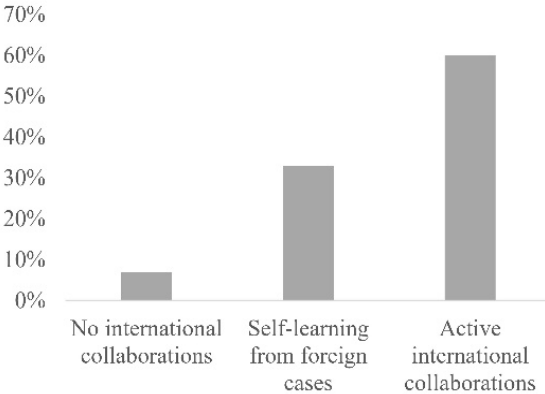
Figure 6. Established international partnerships among Kazakhstan companies.